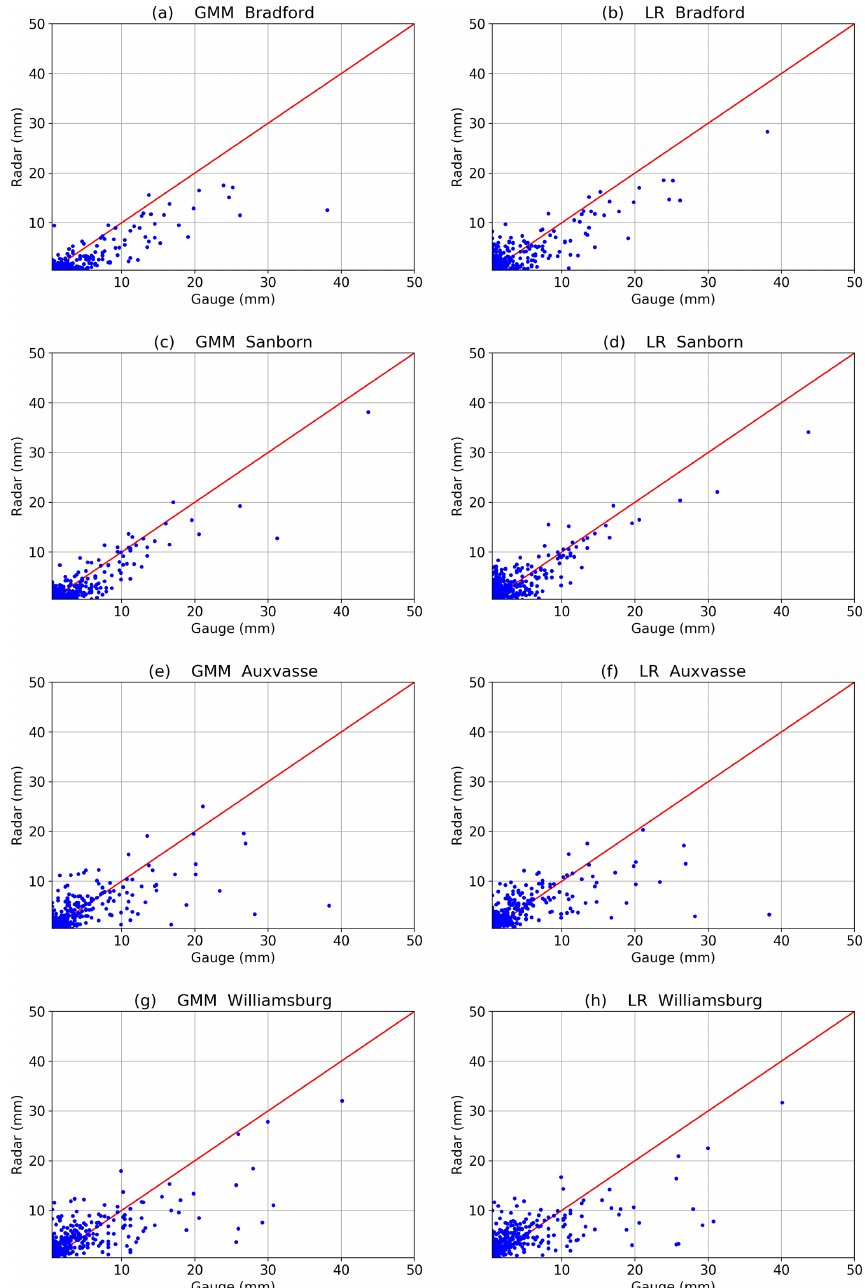
Figure 11. Comparison between hourly radar and gauge data derived from GMM K dp and LR K dp . (a) GMM Bradford, (b) LR Bradford, (c) GMM Sanborn, (d) LR Sanborn, (e) GMM Auxvasse, (f) LR Auxvasse, (g) GMM Williamsburg, and (h) LR Williamsburg. The data were collected between 1 April 2016 and 2 June